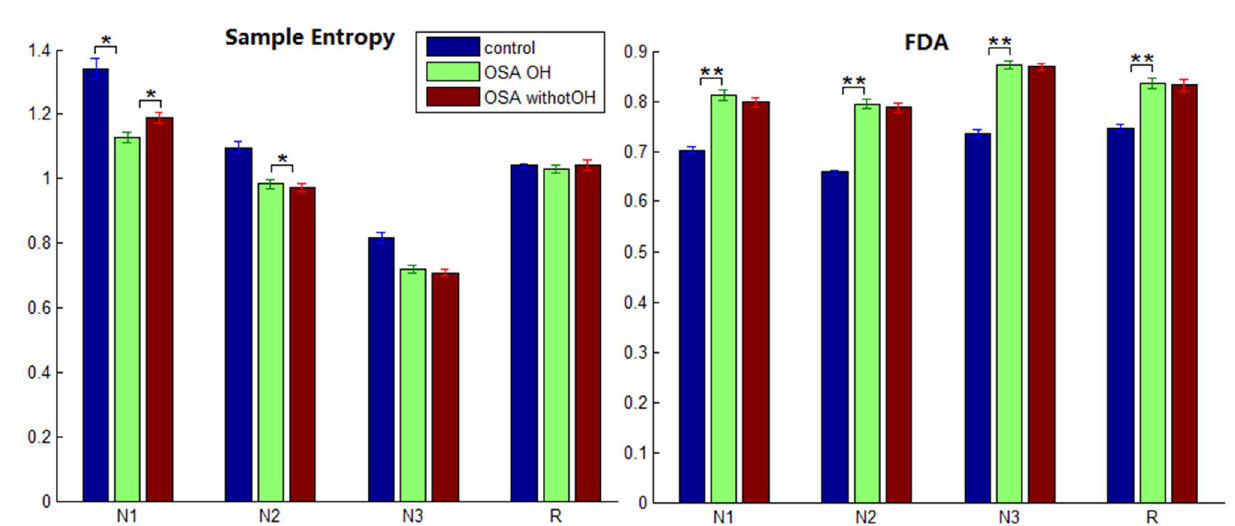
Figure 5. Sample entropy and FDA in four sleep stages in controls, OSA_OH and OSA_withoutOH patients (P* < 0.05, P** <